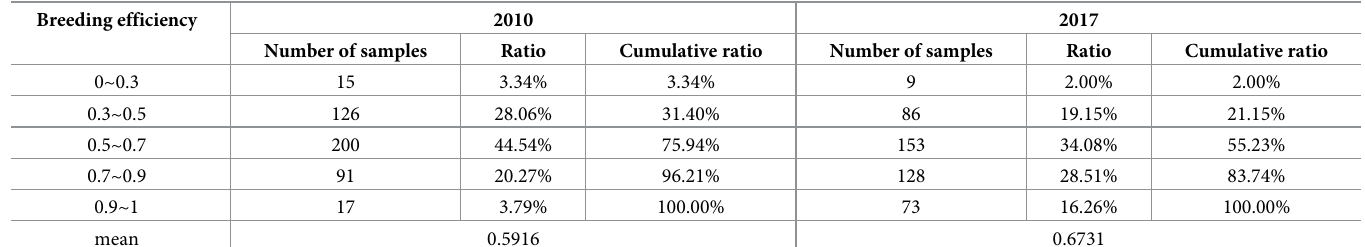
Table 3. Frequency distribution of breeding efficiency of sample herders.